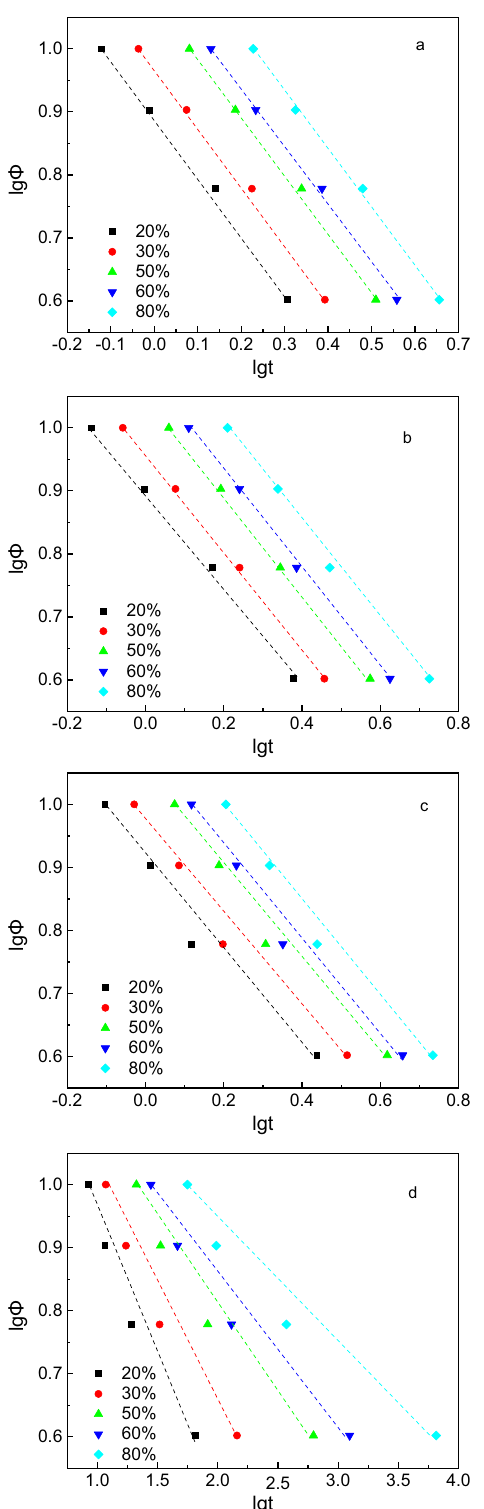
Figure 5: Plots of φ lg versus lgt for the cold crystallization of ( a ) AB, ( b ) ABCa - m ( c ) ABCa - m ( d ) ABCa - n 5 , 11 , and 11 m 5 .